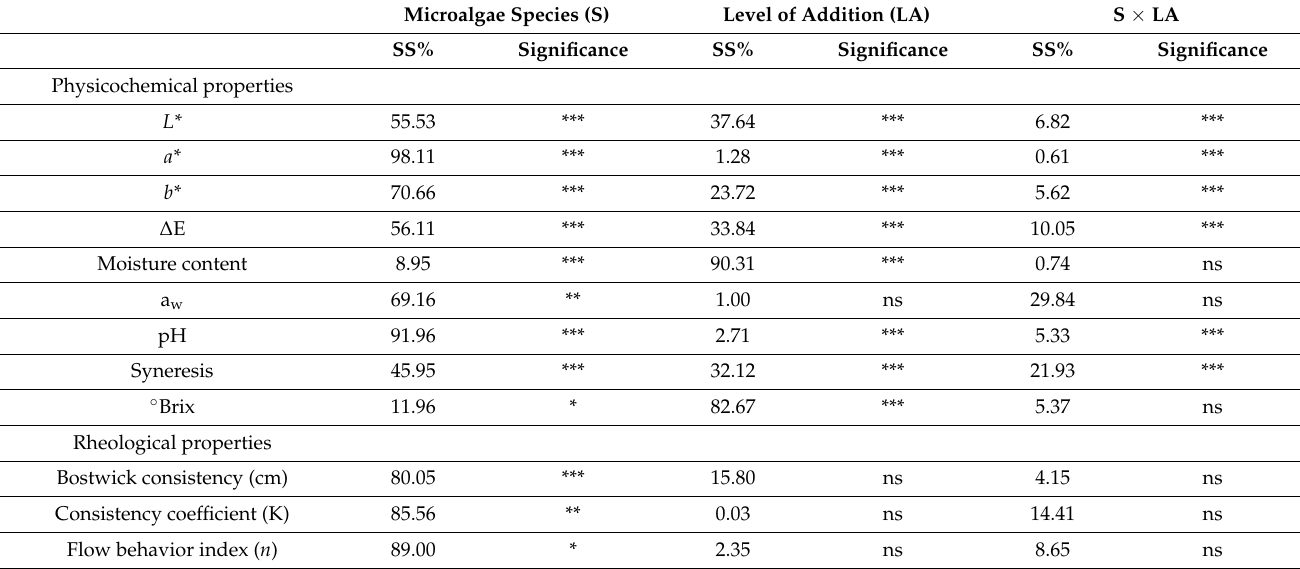
Table 2. Multivariate analysis of the quality characteristics of vegetable creams reformulated with different microalgae and two levels of addition.